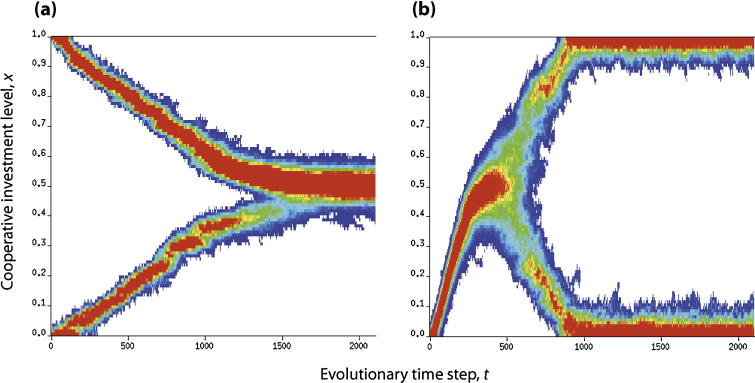
Individual-based simulations of (a) merging and (b) branching in the continuous snowdrift game. Panels show evolutionary changes in the frequency distribution of cooperative investment levels over the population (from high to low: red, orange, yellow, green, blue, white (for 0)). At the outset of each tree, for (a) the population is at a traditionally acknowledged, mixed equilibrium with full-investment (x = 1) or non-investment (x = 0) and for (b) all have no investment (x = 0). In (a), the dimorphic population will eventually merge into a single branch. In (b), in contrast to this, the monomorphic population will first converge to an intermediate level and then diverge into double branches moving to the extreme states, respectively. Parameters: population size N = 10,000, mutation rate μ = 0.01, mutation variance σ = 0.005; for (a), b1 = 7, b2 = −1.7, c1 = 4.6, c2 = −1 (d1 = 1.7, d2 = −1.7); for (b), b1 = 6, b2 = −1.4, c1 = 4.8, c2 = −1.6 (d1 = 1.4, d2 = −1.4). In both cases the interior singular strategy is with x = 0.5. The scaling factor for proportional selection is set so as to be greater than the maximal difference over all possibilities of two samples. (For interpretation of the references to color in this figure legend, the reader is referred to the web version of this article.)